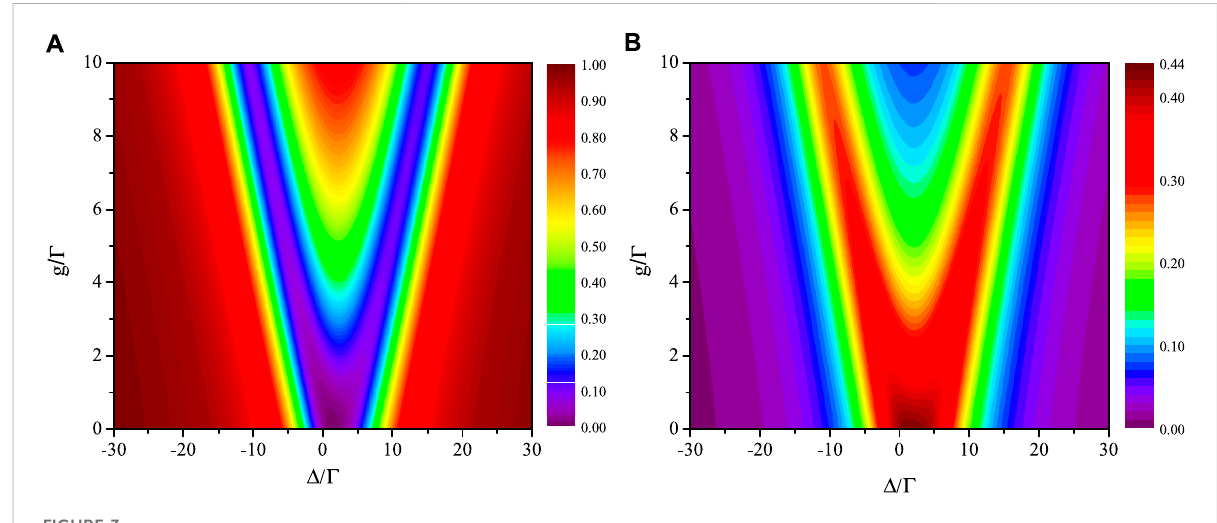
FIGURE 3 Transmission rates T m (A) and T n (B) as a function of the detuning Δ and the coupling strength g between the two atoms under the same atom- waveguide interaction strengths ( Γ a = Γ b = Γ ). The spectra show V-type shapes, indicating the existence of two valleys or peaks. The phase shift between two adjacent coupling points is fi xed to θ = π